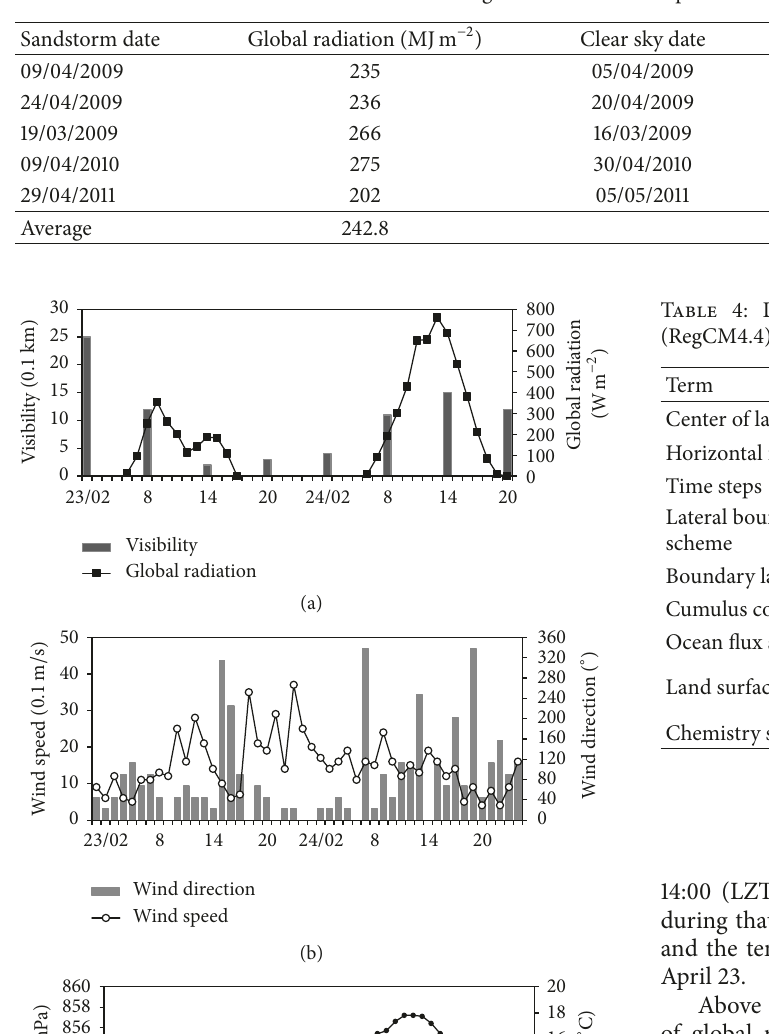
Table 3: Radiation flux changes in five sandstorm processes in Lanzhou during 2009 to 2011.